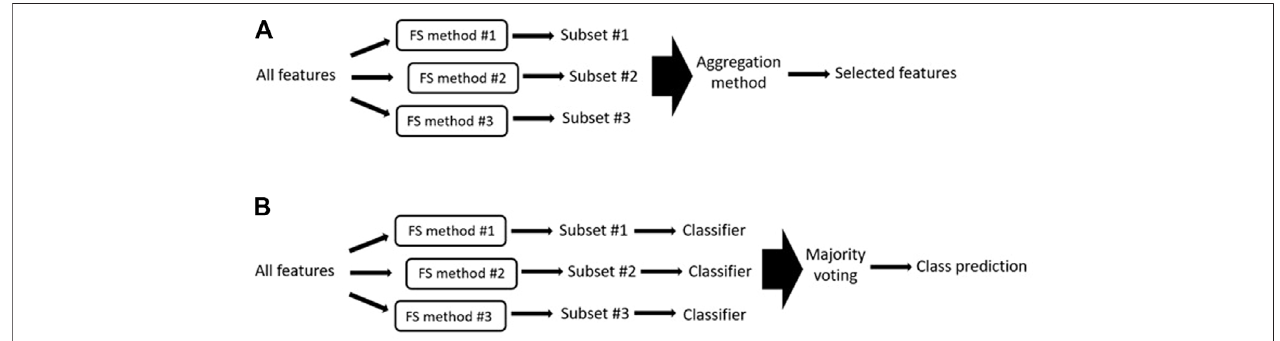
FIGURE6|(A) Generalized illustration ofensemble methods. Inensemble methods, theoutputs ofseveralfeatureselectionmethods areaggregated toobtainthe fi nalselectedfeatures.FS=featureselection. (B)